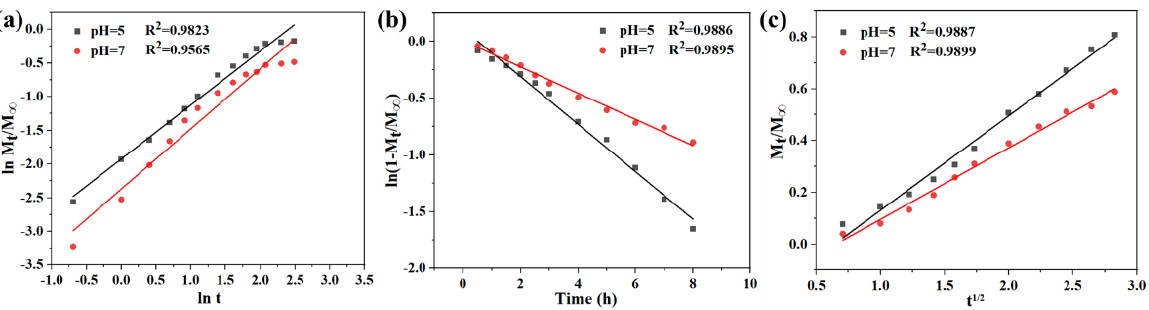
𝑀 𝑡 𝑀 𝑡 ) and time t ( b ), 𝑀 𝑡 and ln 𝑡 ( a ) , ln(1 − and t 1 /2 ( c ) under ) and time t ( b ), M t Figure 6. Linear fitting curves of ln M t and ln t ( a ), ln ( 1 − M t and t 1 /2 ( c ) under M ∞ M ∞ M ∞ 𝑀 ∞ 𝑀 ∞ 𝑀 ∞ acid and neutral